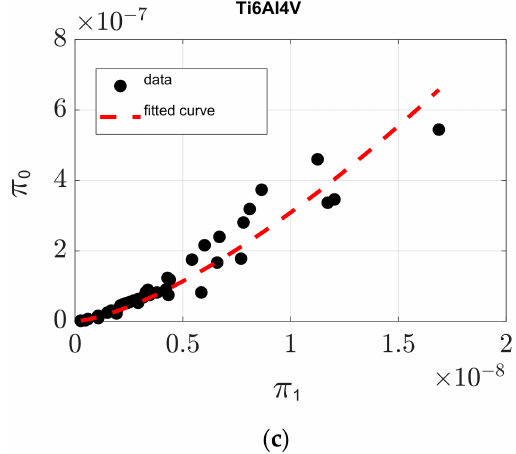
Figure 4. Computed curves of dependent ( π 0 ) vs. independent ( π 1 ) dimensionless products with experimental data collected from: ( a ) In718, ( b ) SS316L and ( c ) Ti6Al4V. A strong relation between dimensionless products is observed. These plots conform the proposed model